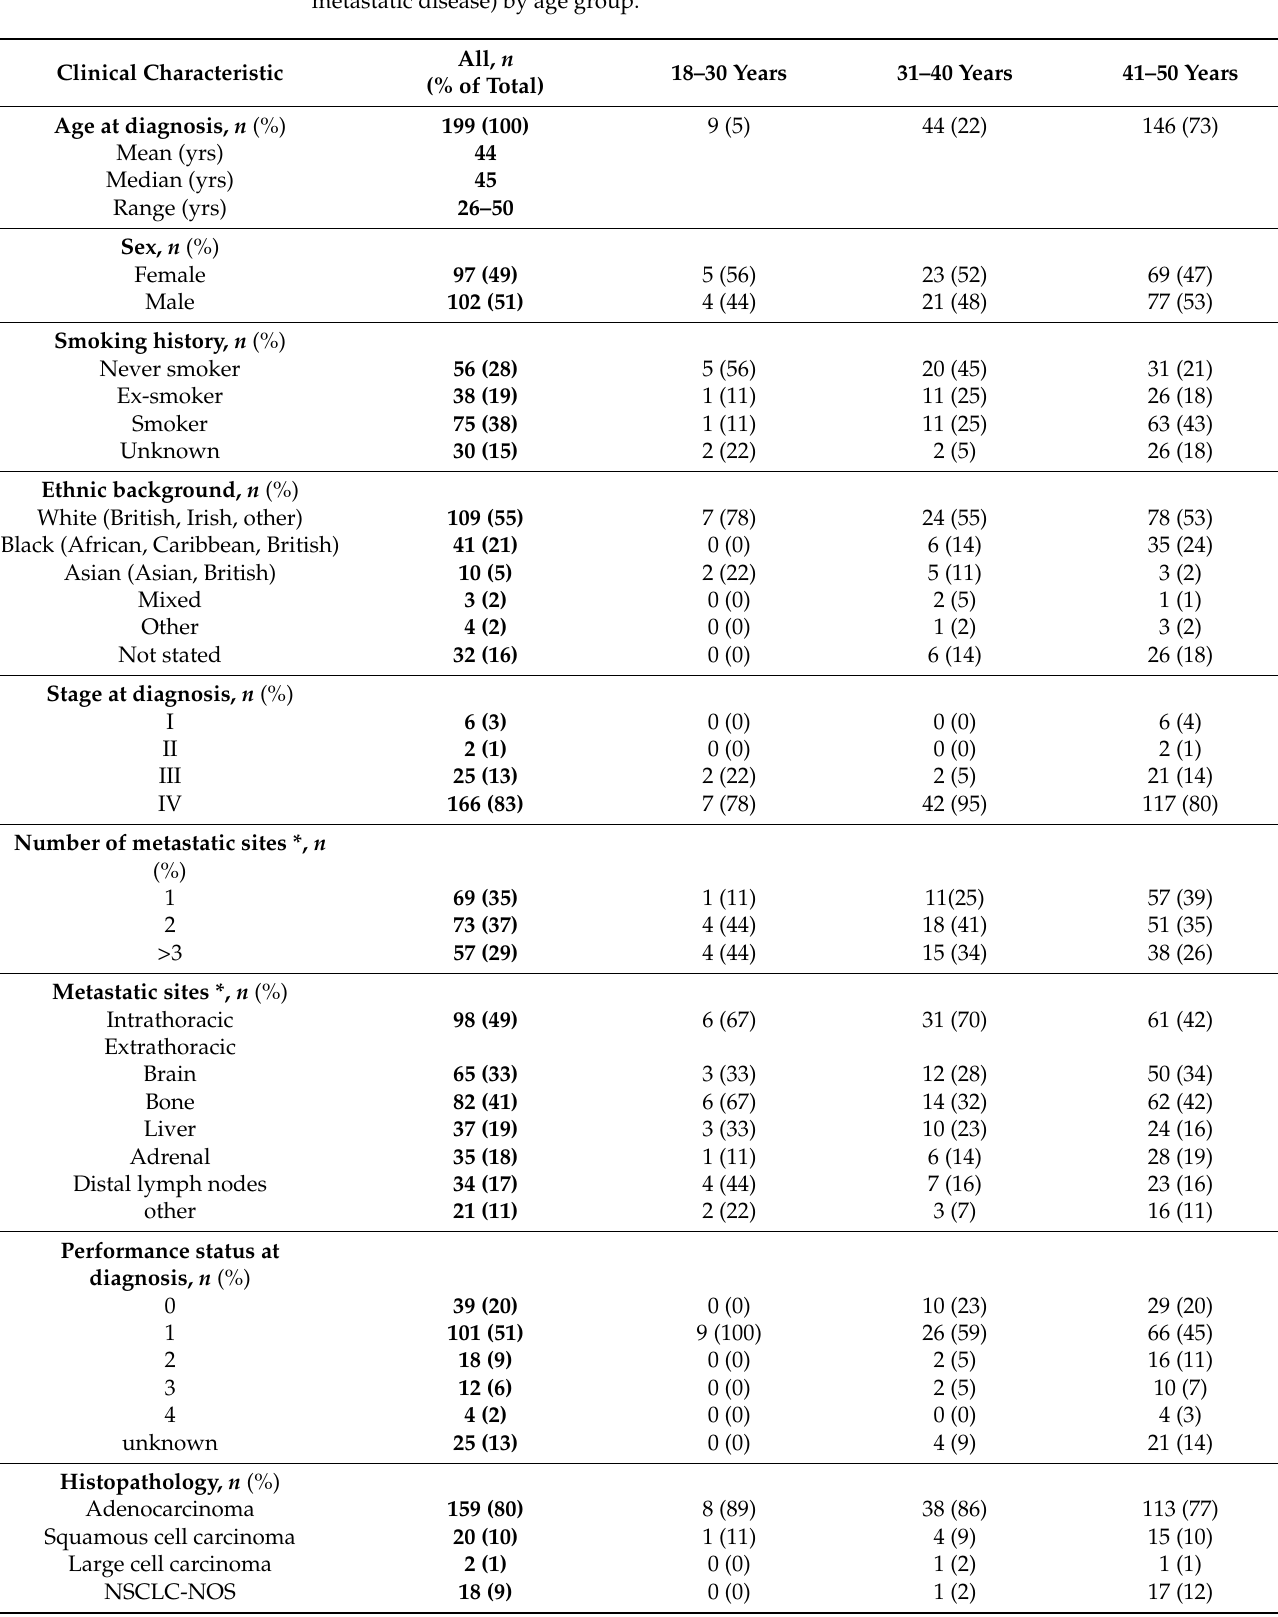
Table 2. Clinical characteristics of all metastatic NSCLC patients ( n = 199; at diagnosis or developed metastatic disease) by age